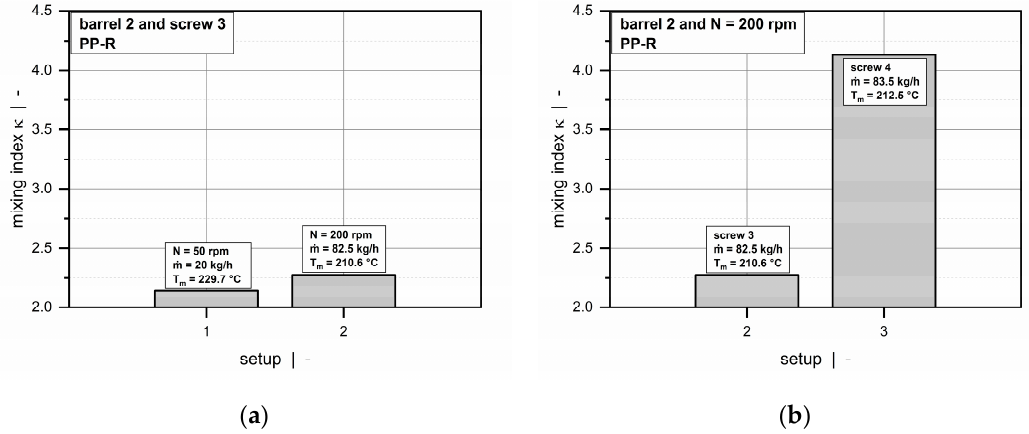
Figure 19. Comparison of mixing indices for various processing conditions: Influence of screw speed for a given screw-barrel-material configuration ( a ) and influence of screw design for a given operating point ( b ).